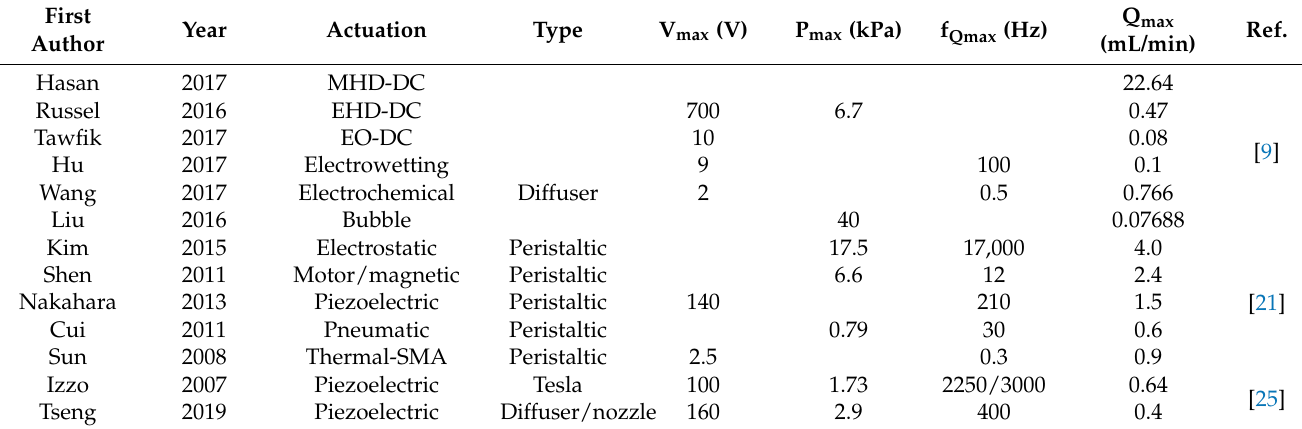
Table 1. Specifications and performance comparisons of valveless